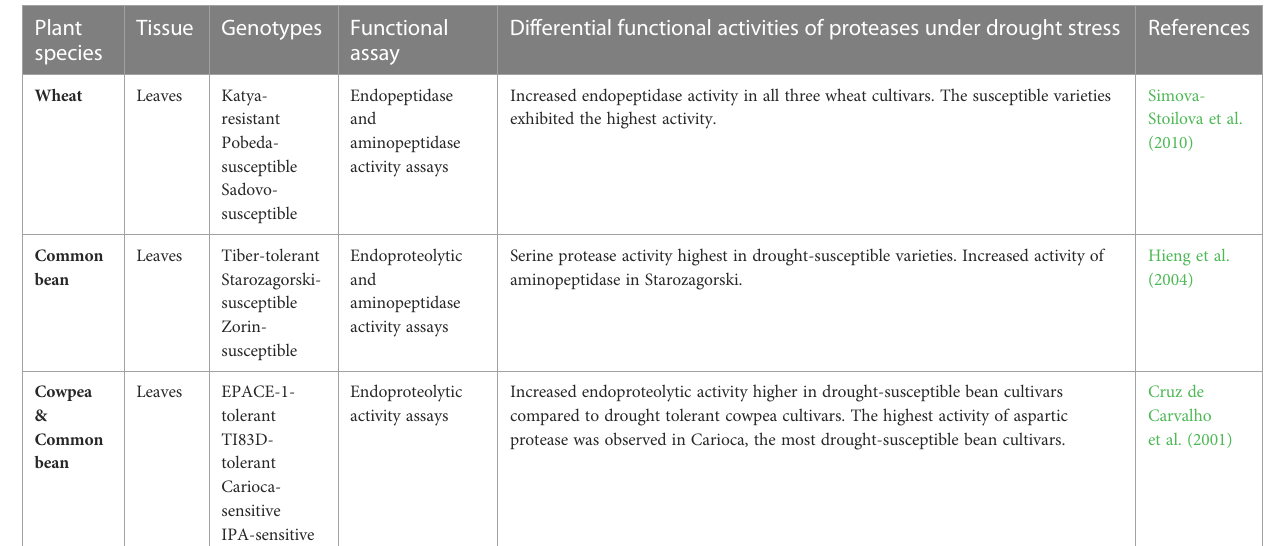
TABLE 4 Studies showing differential functional activities of proteases in plants under drought